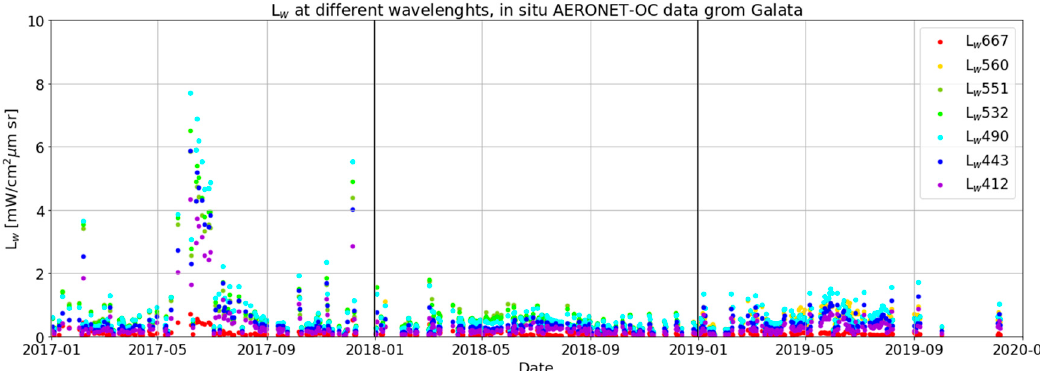
Figure 3. Water-leaving radiance measured for different wavelengths at Galata AERONET-OC site in the Black Sea.